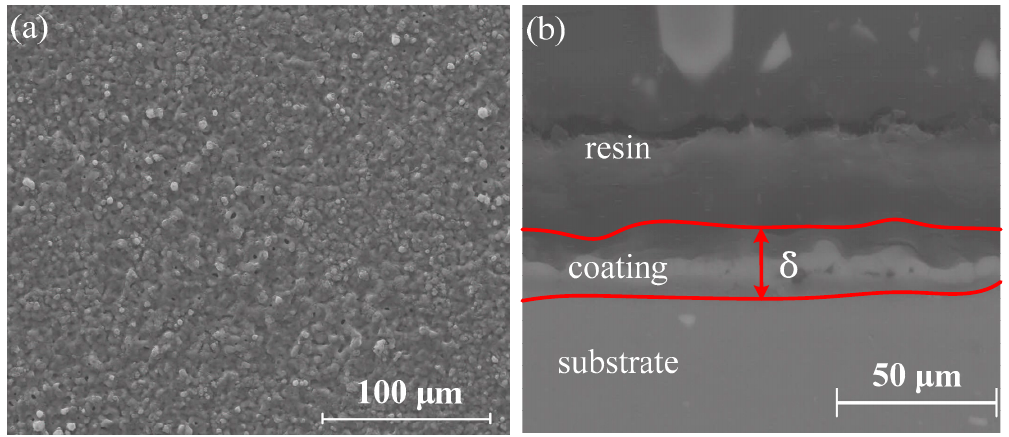
Figure 5. ( a ) Surface morphology, ( b ) cross-section, ( c ) chemical compositions, and ( d ) phases of the plasma electrolytic oxidation